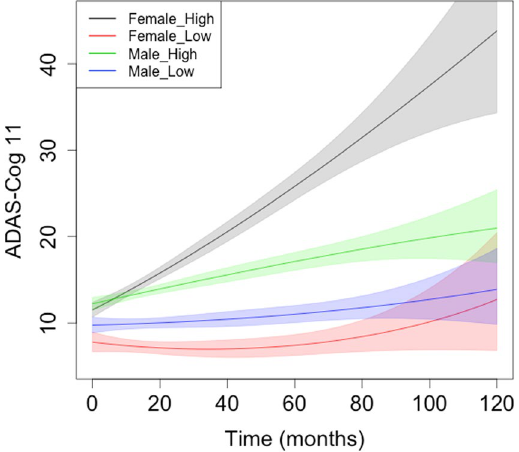
Figure 2. ADAS-Cog11 Slopes in subjects with high or low probability of MCI due to AD. X-axis depicts maximum duration of follow up. Y-axis depicts ADAS-Cog11 scores. MCI subjects have been grouped using CSF t-tau/A β 42 ratio as having “high” or “low” probability of MCI due to AD. Slopes and confidence intervals are derived from a simple quadratic model (polynomial regression) by sex over time without any other covariates. Data comprises pooled MCI subjects from ADNI-1 and ADNI-2. Female subjects with high probability of MCI due to AD showed greater decline than the other groups.